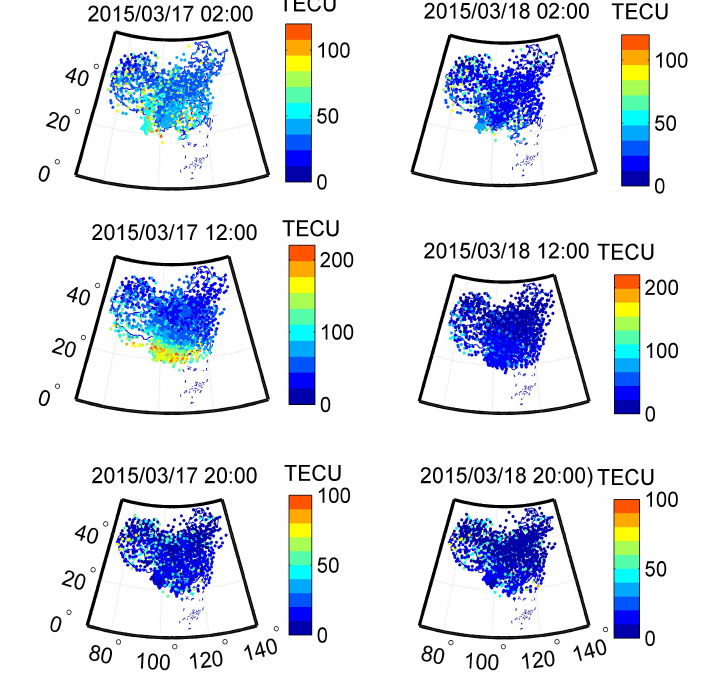
Figure 4. Variations of Slant TEC (STEC) at the Ionospheric Pierce Points (IPPs) at UTC 2:00, 12:00, 20:00 on 17–18 March 2015 (H = 350